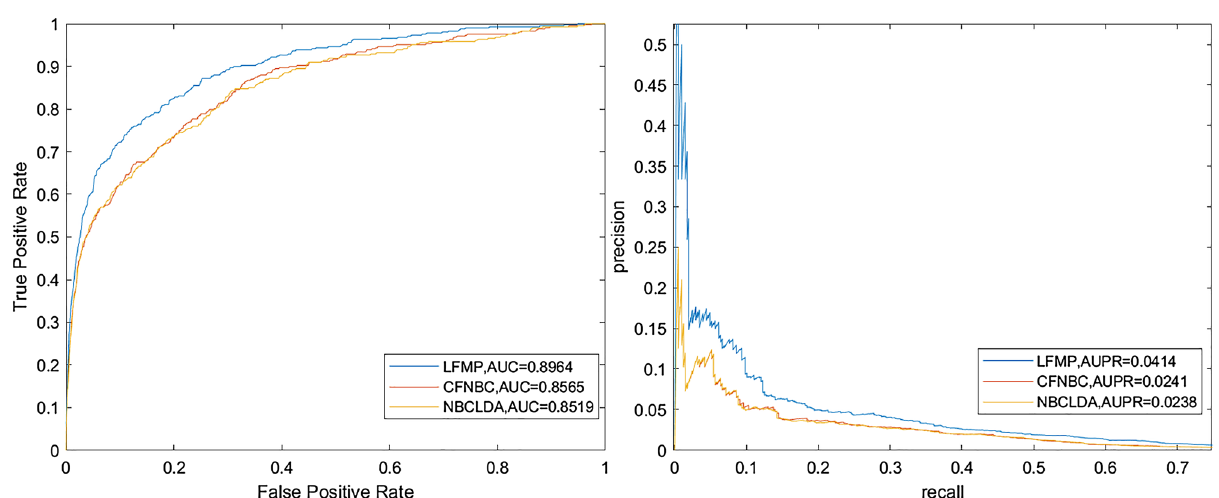
Figure 2. ROC and AUPR comparison between LFMP model and other advanced models based on 407 known lncRNA disease associated LOOCV